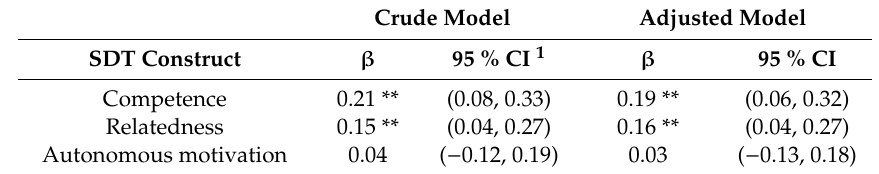
Table 4. Linear regression models on the association of healthy dietary pattern and SDT variables.